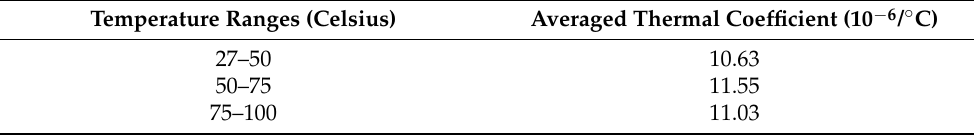
Table 4. Thermal coefficient of linear expansion in different temperature